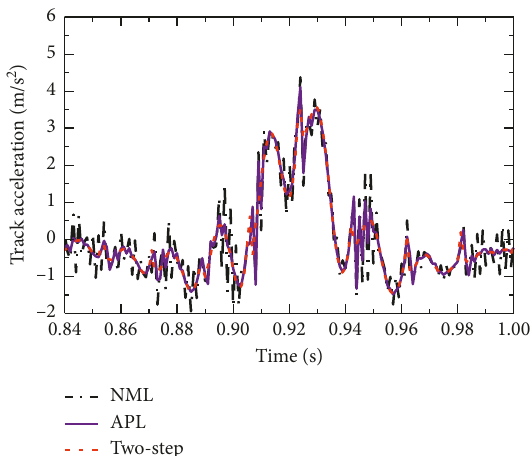
Figure 7: Accelerations of the midpoint of the track without irregularity for an integration step of 10 − 3 Table 2: Multiwheel vehicle and multilayer track model parameters. Parameters (units) Value